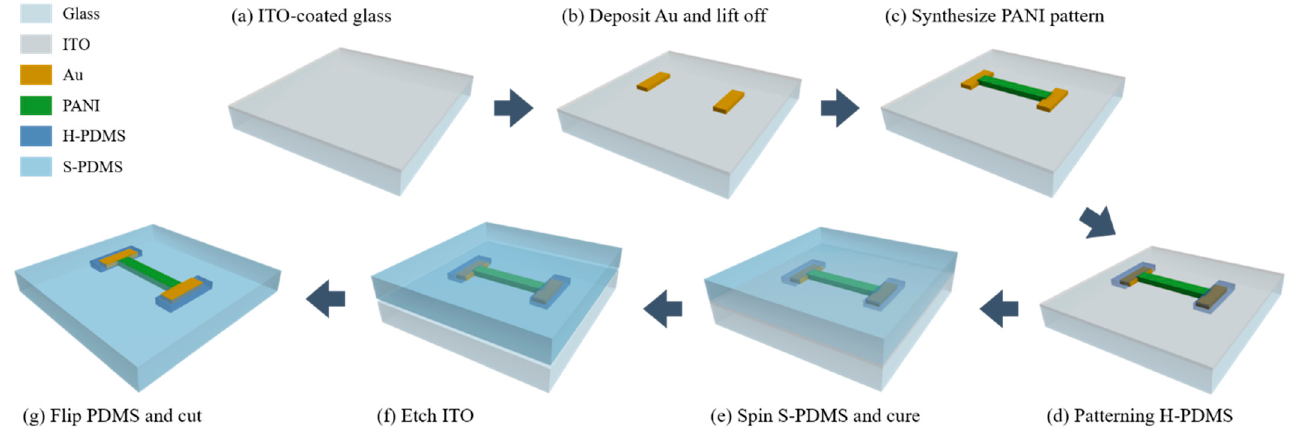
Figure 1. Fabrication of PANI/Au/H-PDMS strain sensor: ( a ) preparing the auxiliary substrate with a sacrificial layer; ( b ) formation of MCL; ( c ) formation of sensing material; ( d ) formulation of the buffer layer; ( e ) formulation of the stretchable substrate; ( f ) separating the stretchable substrate and the auxiliary substrate; ( g ) cutting PDMS into a dumbbell